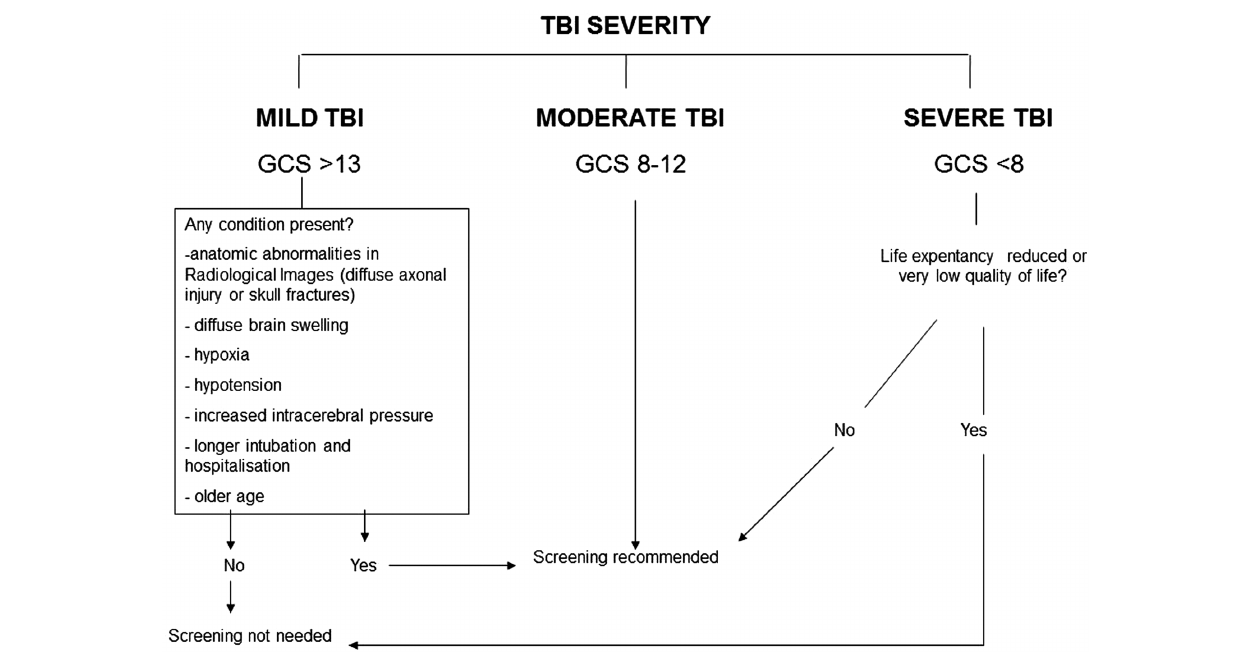
FIGURE 1 | Recommendations for screening in patients with traumatic brain injury (TBI) according to Glasgow Comma Scale (GCS).